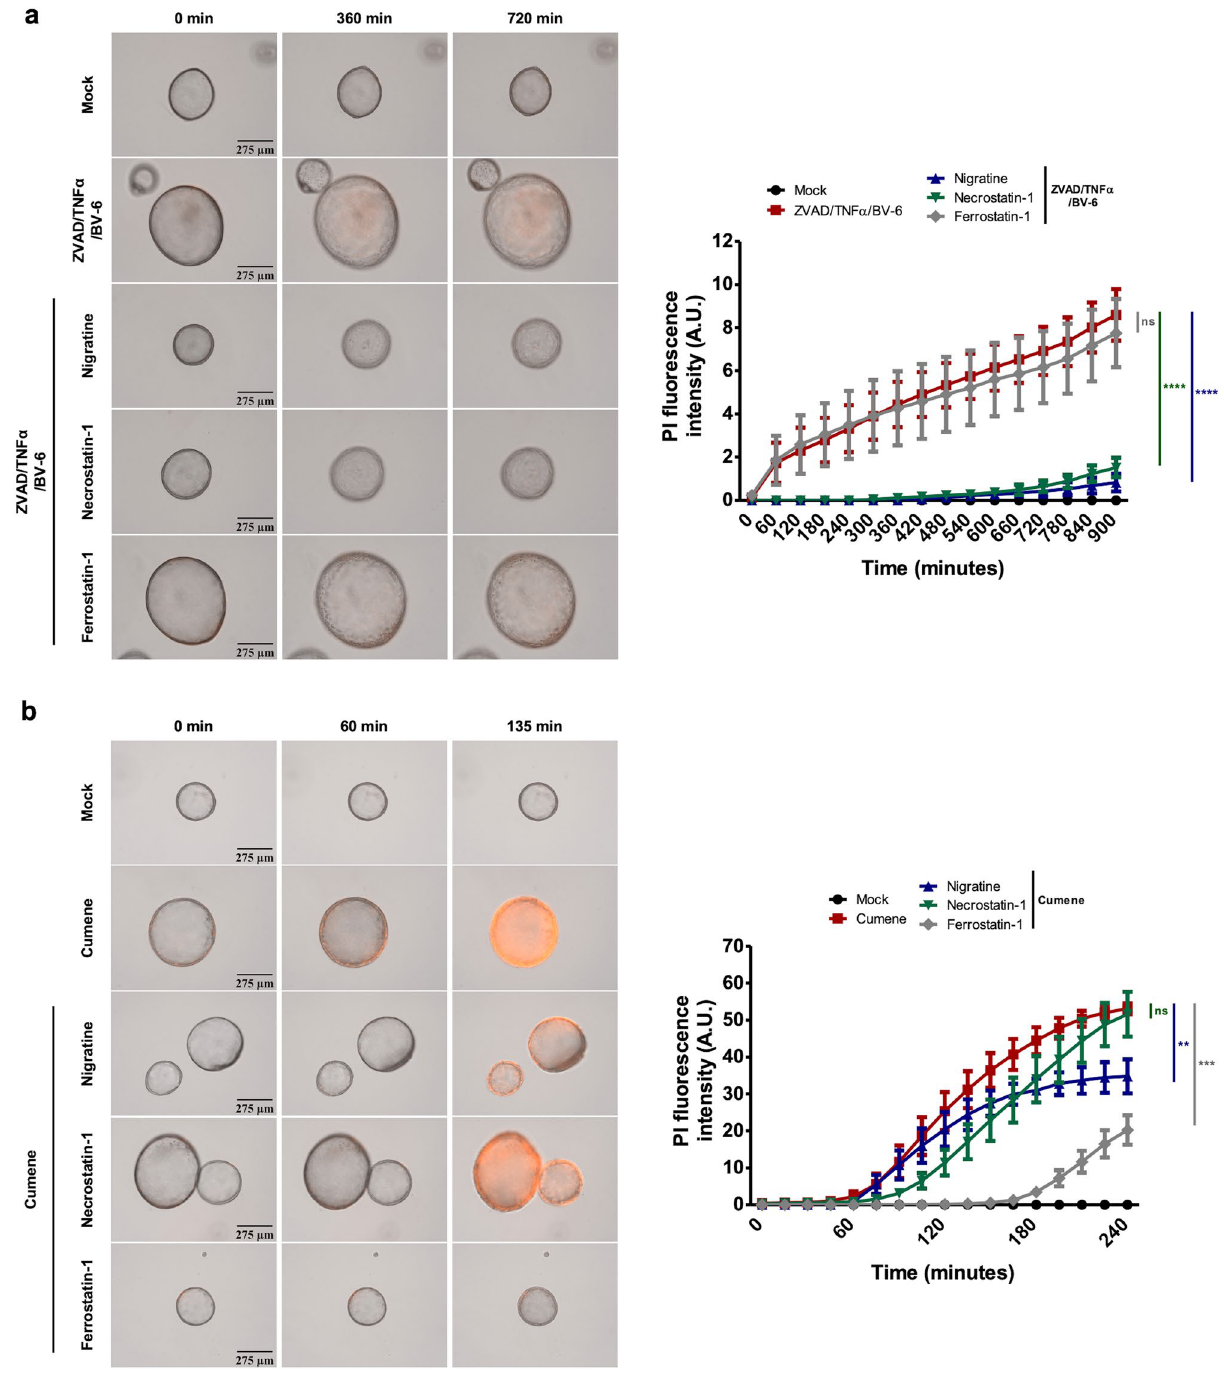
Figure 6. Nigratine protects human bronchial organoids from necroptosis and ferroptosis. ( a ) Time- lapse microscopy and the associated quantifications of the measure of plasma membrane permeabilization using propidium iodide incorporation in human primary bronchial organoids stimulated with the mix of 40 μM Z-VAD, 100 ng/ml Human TNF-α and 5 µM BV-6 in presence or absence of 25 μM nigratine, 40 μM necrostatin-1 or 40 μM ferrostatin-1 for 15 h. Data are plotted as means + /− SEM. pValue calculated by t -test. ( b ) Time-lapse microscopy and the associated quantifications of the measure of plasma membrane permeabilization using propidium iodide incorporation in human primary bronchial organoids stimulated with 800 µM of cumene hydroperoxide in presence or absence of 25 μM nigratine, 40 μM necrostatin-1 or 40 μM ferrostatin-1 for 4 h. Data are plotted as means +/− SEM. pValues were calculated by t -test (**pValue < 0.01, ***pValue < 0.001, ****pValue <